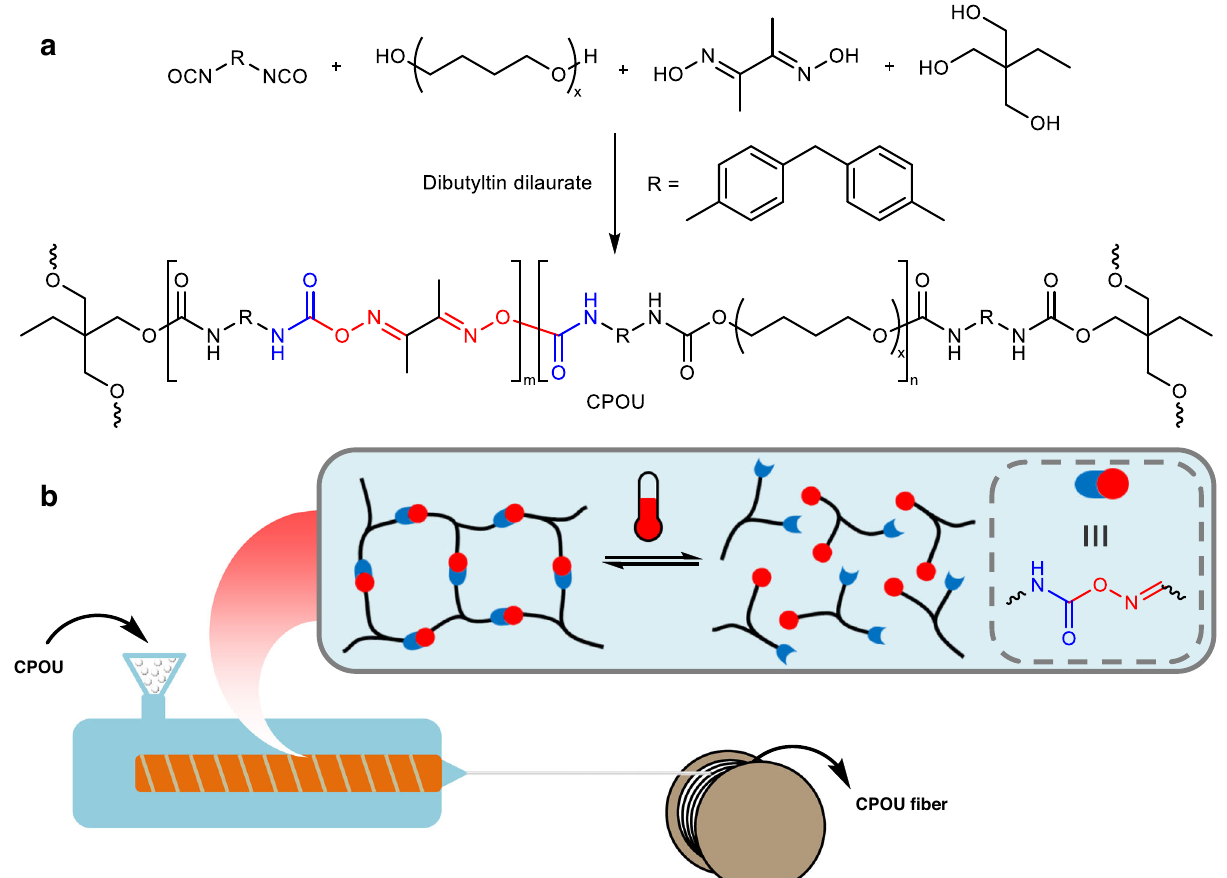
Fig.1|DesignandfabricationofCPOU fi ber.a Moleculardesignofcovalentlycross-linkedCPOU. b Schematicofthemelt-spinningprocessandcorrespondingmolecular evolution of